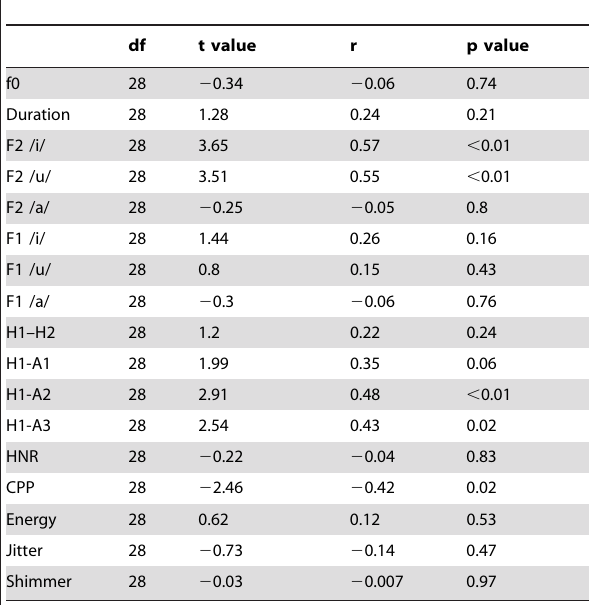
Table 12. Zero-order correlations between vocal attractiveness ratings and each acoustic measure for the 30 female voices.